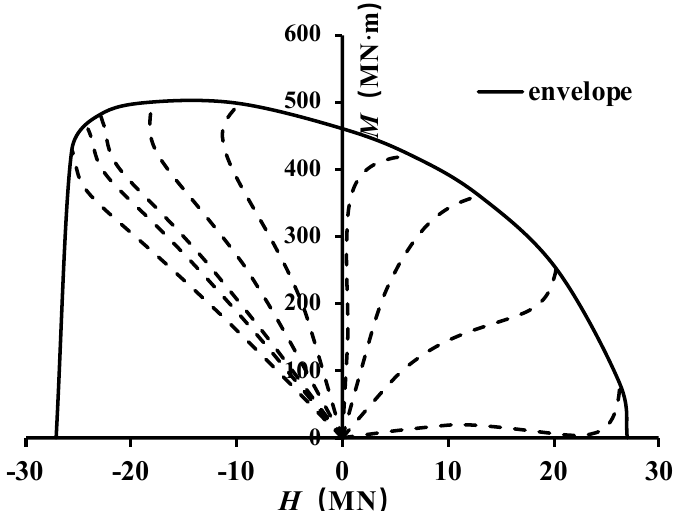
Figure 5. Carrying capacity envelope by fixed displacement ratio method.